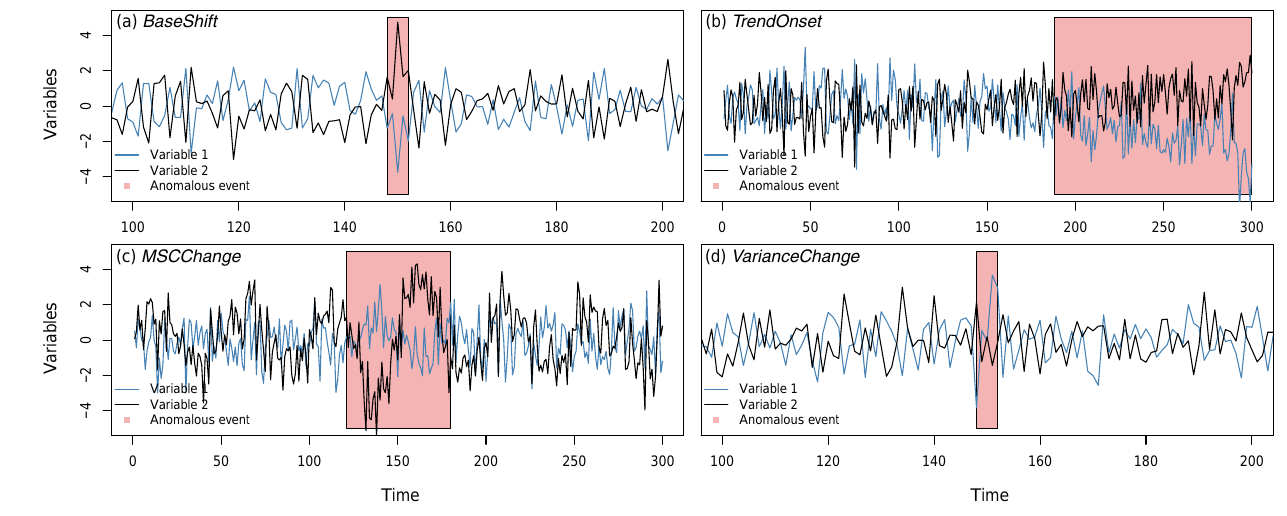
Figure 2. Visualization of the four different event types (a–d) with two variables along time t i,j = 1 ,...,T ( T = 300). The two variables contain an anomalous event (red shape) that is propagated through the underlying independent components with randomly drawn weights within the generation process of the variables. For illustration purposes two variables are shown for one specific magnitude of the anomaly. The artificial data farm encompasses 10 variables and anomalous events of 20 different magnitudes ranging from very subtle to exceptionally high